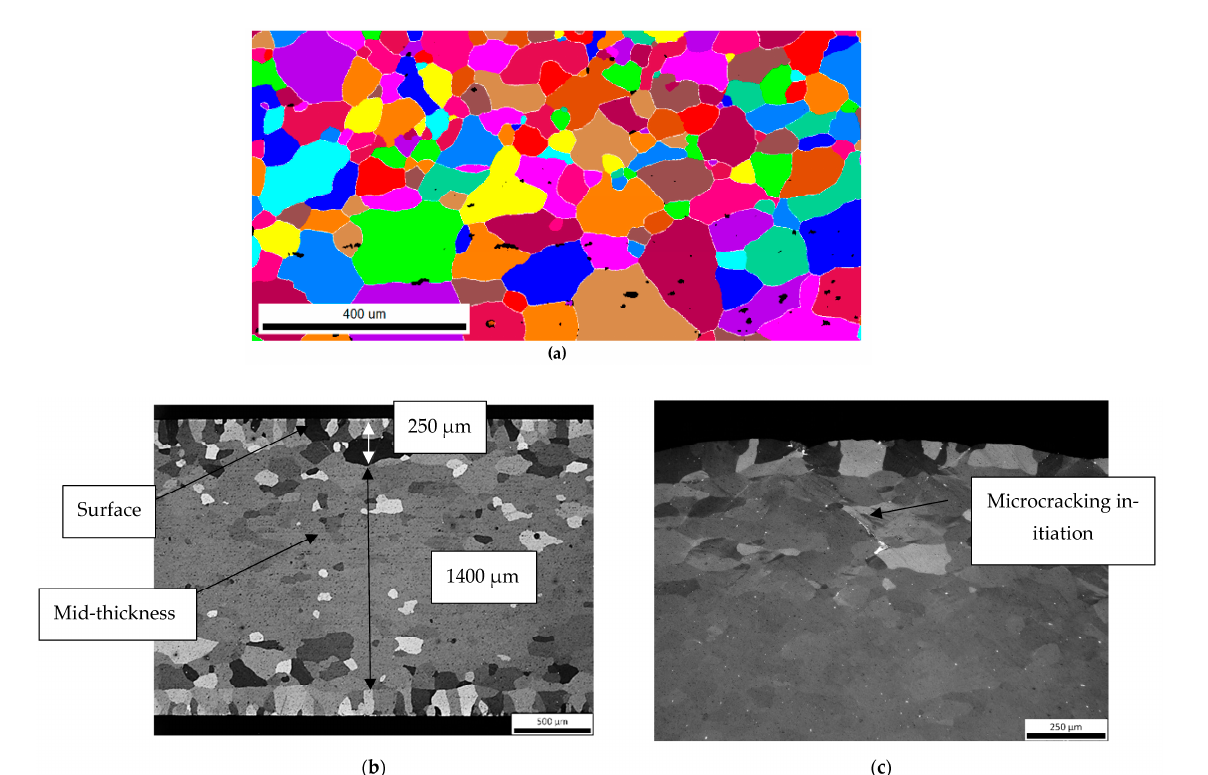
Figure 2. ( a ) EBSD grain structure map of the profile. ( b ) Grain structure of the WQ sample away from the bending region (unaffected area). ( c ) Development of “orange peeling” on the bent surface and subsurface microcracking initiation in the SC sample.